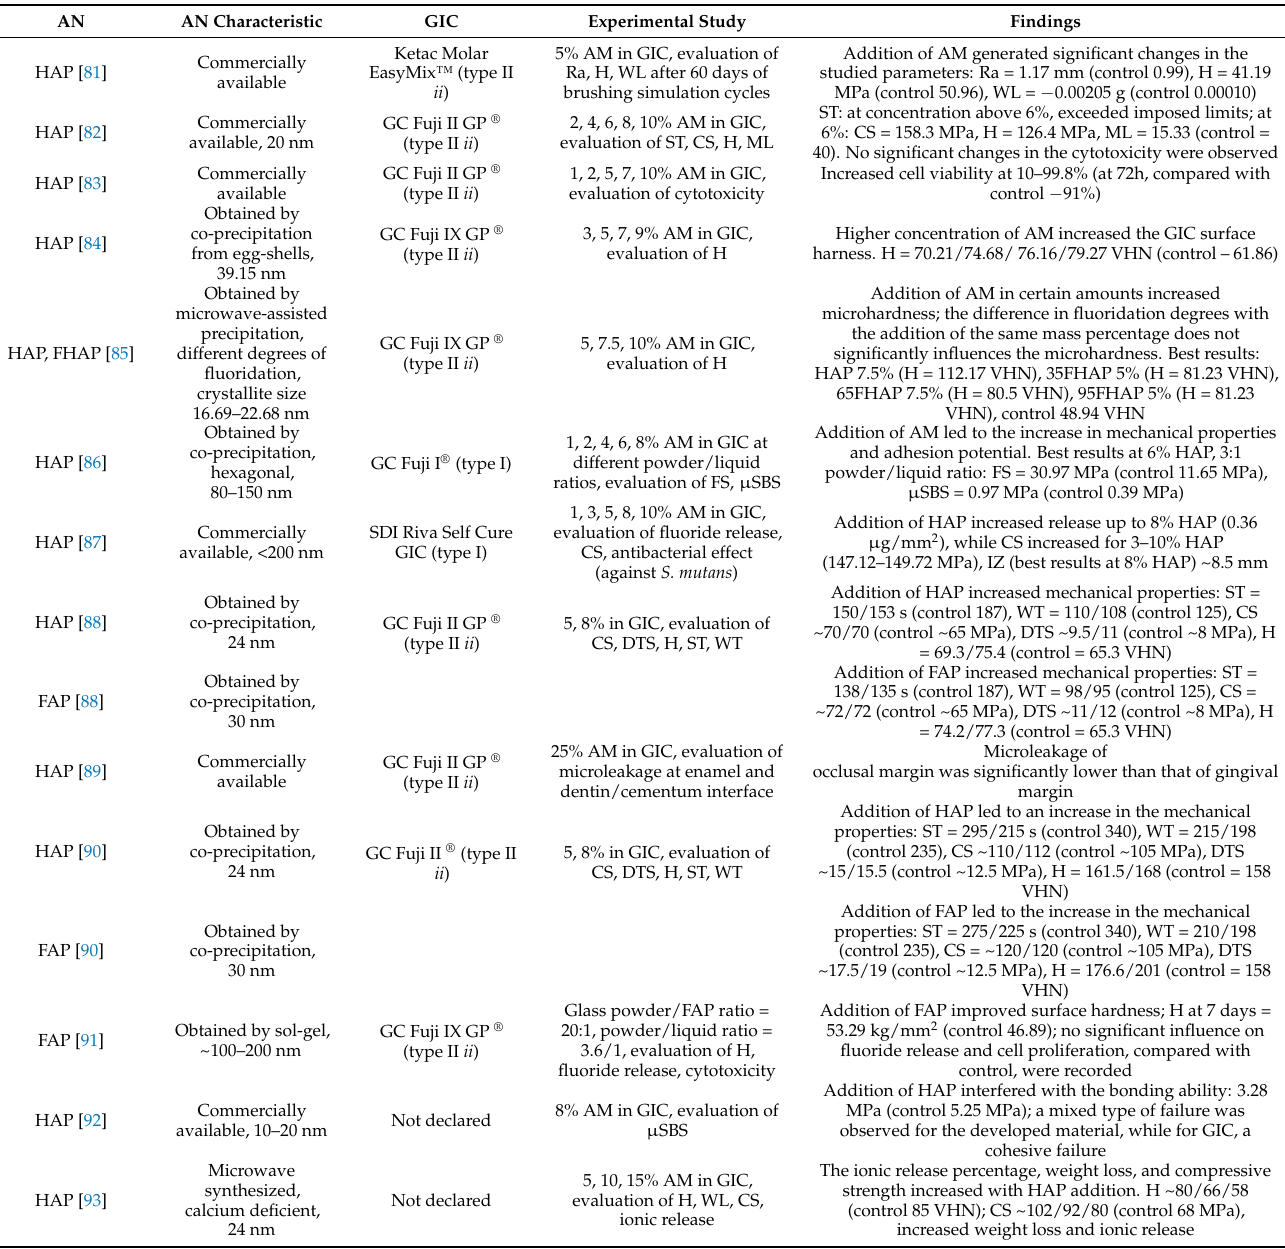
Table 5. Examples of incorporation of apatitic nanomaterials in GIC (references presented in chrono- logical order) 1